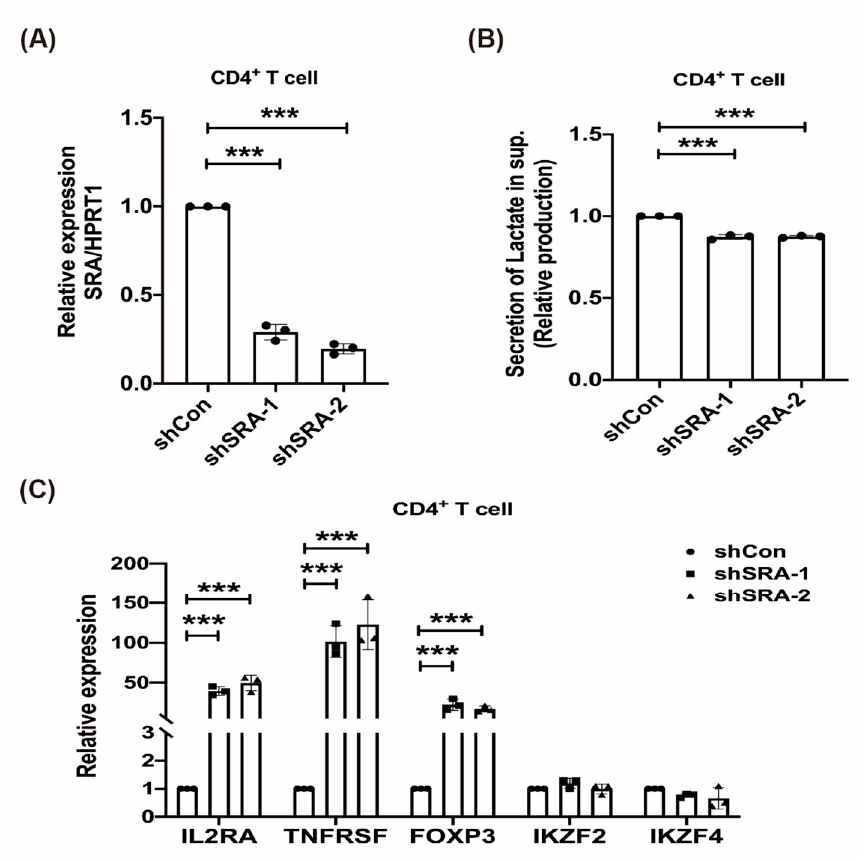
Figure 3. LncRNA SRA suppresses CD4+ Treg function. ( A ) LncRNA SRA expression analysis of CD4+ MOLT4 Tregs (shCon and shSRA). ( B ) SRA induces lactate metabolism. Lactate was quantified in CD4+ MOLT4 Tregs (shCon and shSRA) and ( C ) mRNA expression analysis of Treg signature genes (shCon and shSRA). SRA silencing caused a sharp increase in the amount of mRNA of genes that promoted Treg function. Mean ± SD, Student’s t -test (unpaired, two-sided). * p < 0.05, ** p < 0.01, *** p < 0.001.